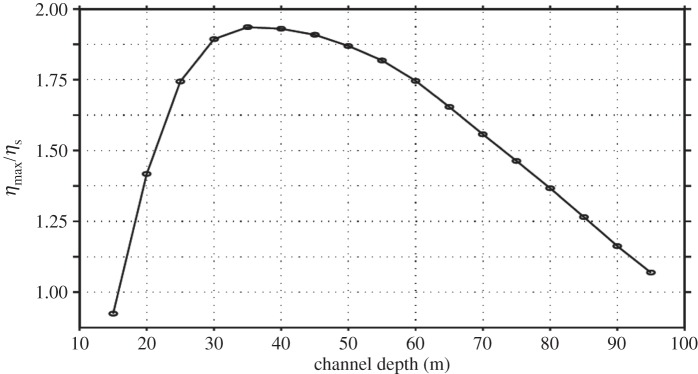
Variation in the resonance factor () for different water depths along a narrow long channel.